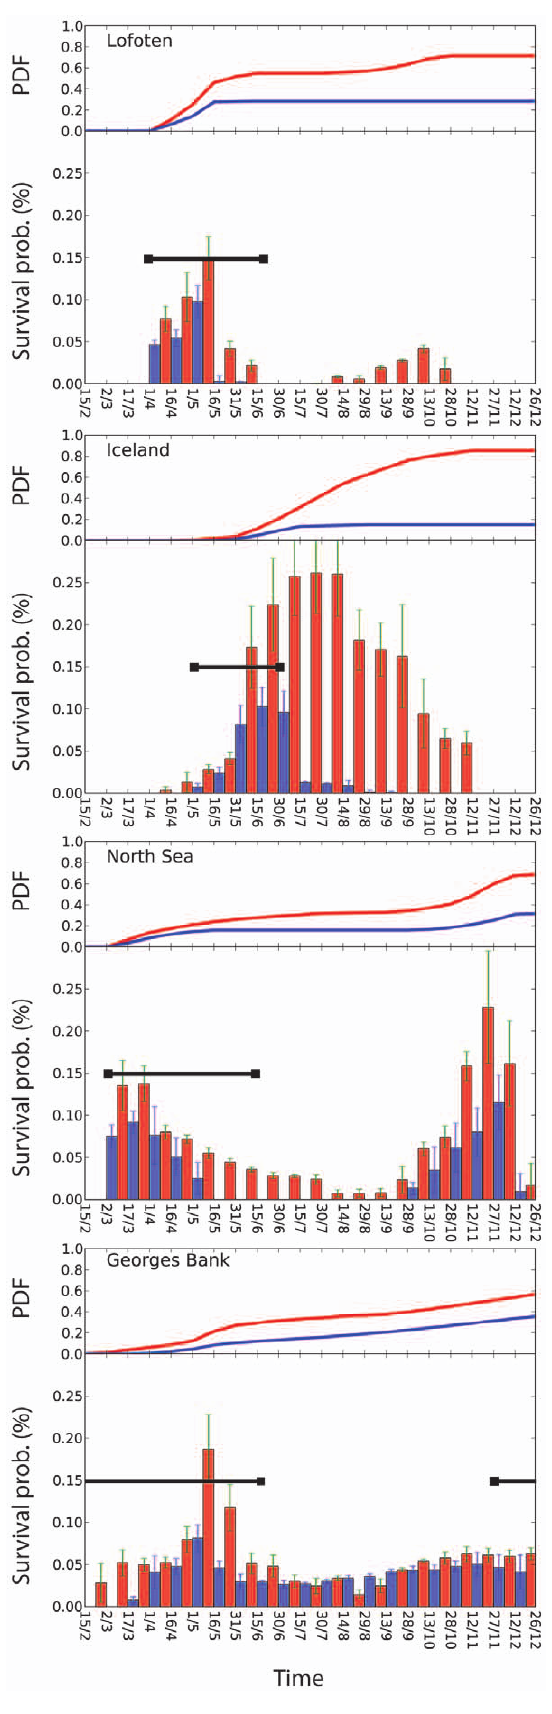
Figure 4. Average and cumulative survival probabilities. The upper panel shows the probability density function (PDF) of cumulative survival through the year. The slope of the PDF indicates the time period of importance to the cumulative yearly survival. In Lofoten, a short time window during spring accrues most of the cumulative survival during the year, while on Georges Bank, the slope is more continuous suggesting that a longer time window when high growth and survival rates are possible. The lower panel shows the average probability (%) of larval cod survival from hatching to age 30 days in warm (red) and cold (blue) years at four different spawning locations in the North Atlantic. The black thick lines indicate the time-period when larval fish 0–30 days old are observed in the water